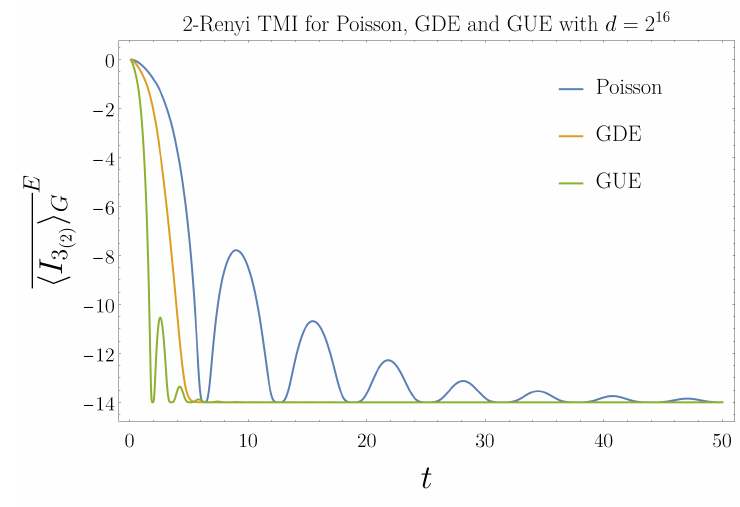
Figure 7: The upper bound for the tripartite mutual information, shown in Eq. (51) for the Poisson, GUE and GDE ensembles for d = 2 16 . While GDE has no oscillations, GUE and Poisson exhibit oscillations which are reduced with the system size. An analysis of the oscillations is obtained in Eq. (53) and Eq. (54) respectively. This plot is already shown in [ 1 ] and reported here for